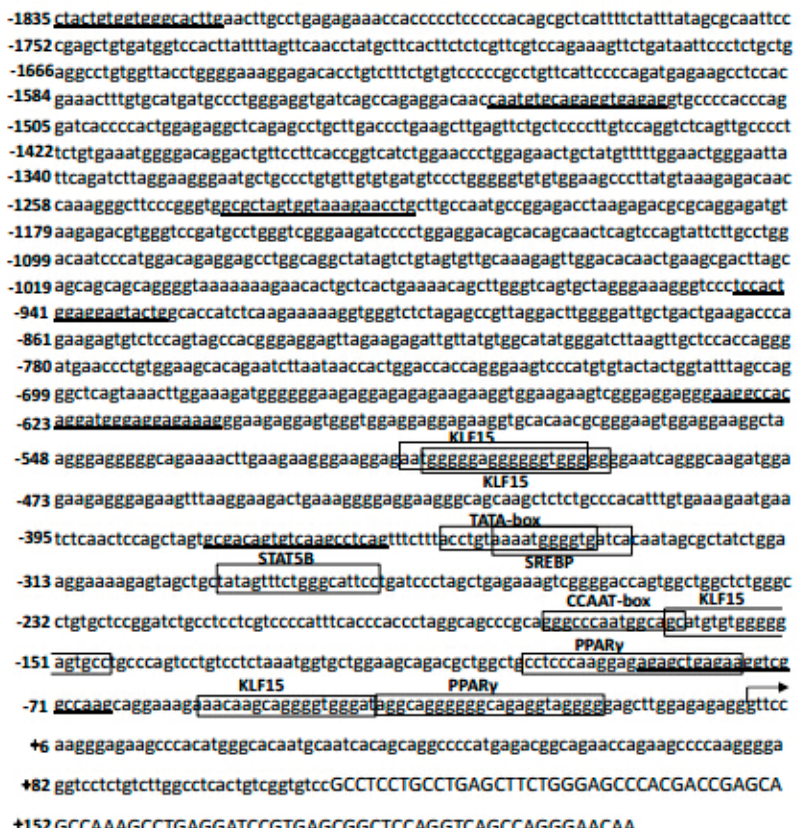
Figure 3. Sequence of the bovine SLC27A1 promoter and a segment of exon 1. The SLC27A1 TSS is marked with an arrow, with exon 1 indicated by capital letters. Unidirectional deletion primers are underlined, and boxes indicate potential sites of transcription factor binding. Animals 2019 , 9 , x